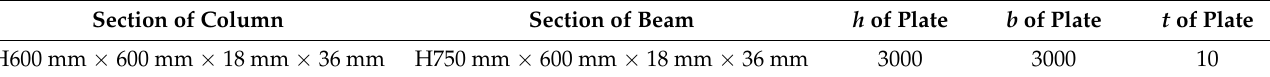
Table 1. Parameters of SPSW model (Unit: mm). Section of Column Section of